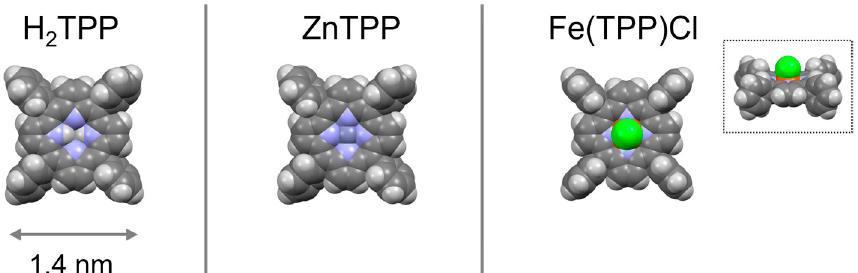
Scheme 1. Sketch of three different porphyrins used in the experiments: dark grey balls = C-atoms; light grey balls = H-atoms; violet balls = N-atoms; dark violet ball = Zn-atom; red ball = Fe-atom; green ball = Cl-atom; the average molecular size is indicated at the bottom. In the Fe(TPP)Cl molecule, the Cl-atom is placed axially on top of the Fe-atom; a side view of the molecule is reported in the inset.